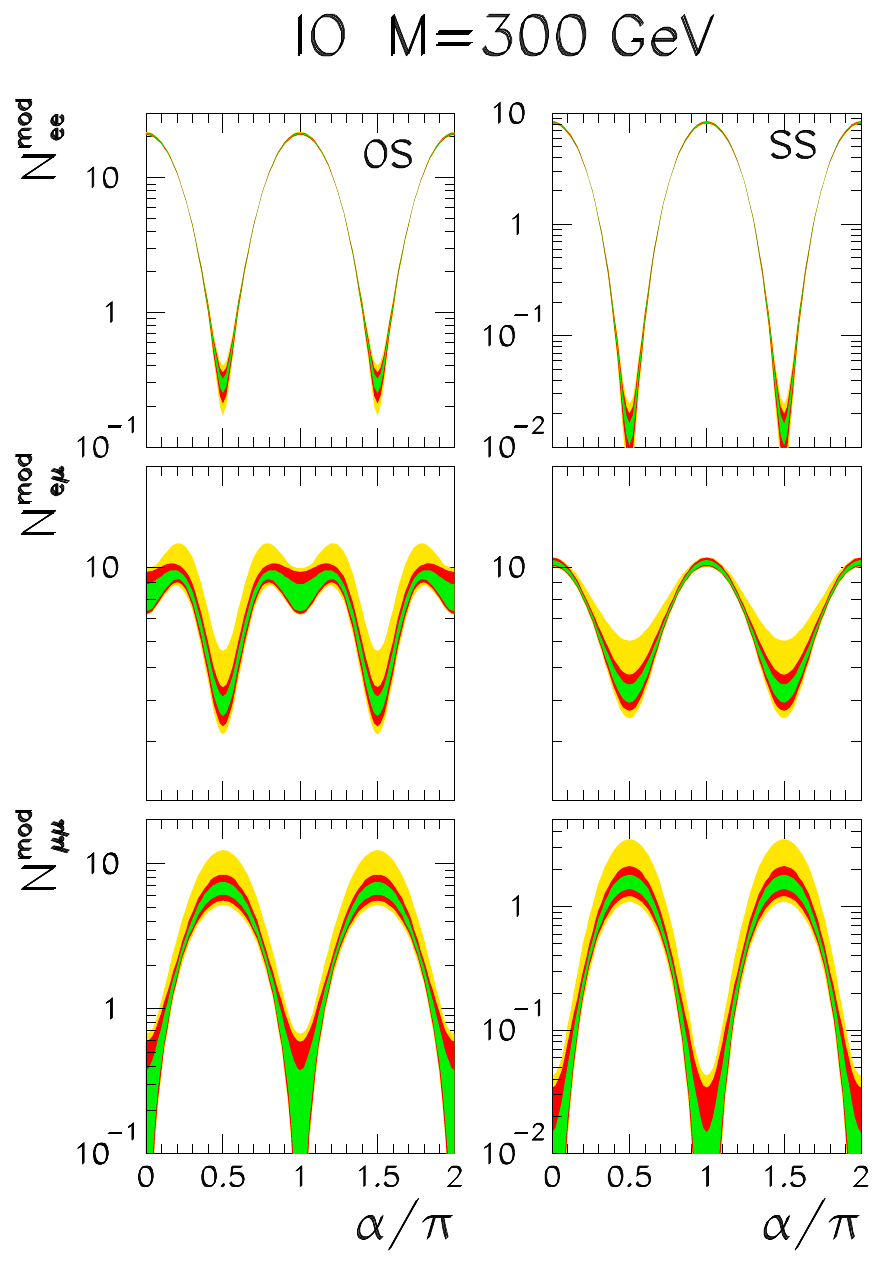
Figure 4 . Same as (cid:12)gure 4 for